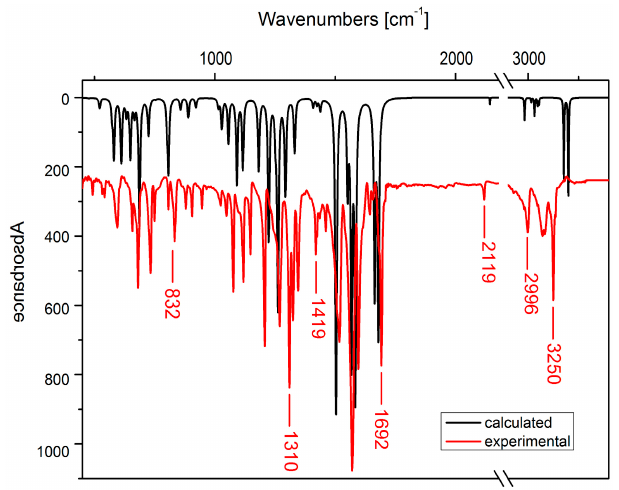
Figure 4. Experimental (red line) and calculated (black line) IR spectra for 6-chloro-7-propargylamine- 5,8-quinolinedione 2a (450–3500) cm − 1 . See Table 3 for band assignments. Crystals 2017 , 7 , 15